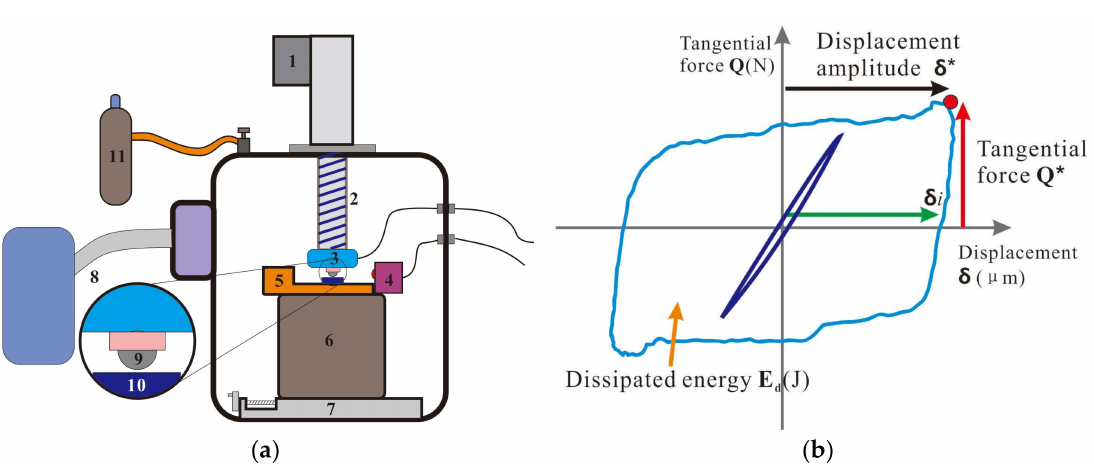
Figure 1. Schematic view of experimental equipment ( a ) and fretting loop analysis ( b ). ( 1 ) servo electric cylinder; ( 2 ) lead screw; ( 3 ) three-dimensional pressure sensor; ( 4 ) laser copolymerization sensor; ( 5 ) piezoelectric ceramics; ( 6 ) base; ( 7 ) screw module; ( 8 ) vacuum pump system; ( 9 ) ball sample; ( 10 ) plate sample; ( 11 ) gas transmission system. Table 1. Parameter of the fretting wear